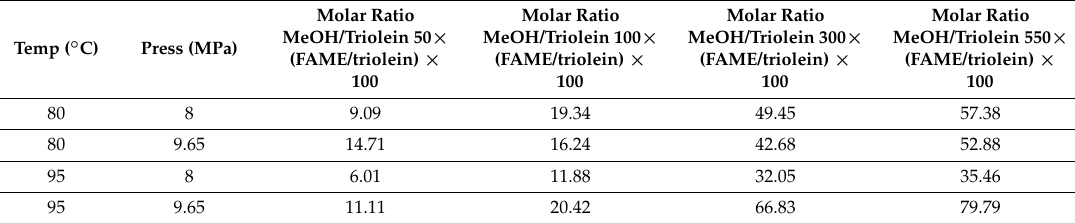
Table 3. Simulated Fractional FAME Yield using Methanol/TG Molar Ratios.